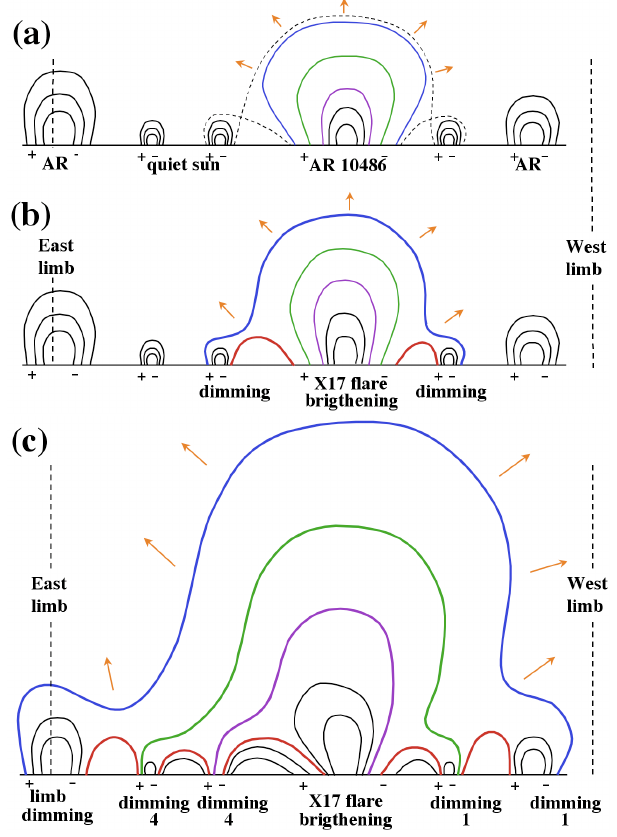
Fig. 15. Dimming spreading due to reconnection (mechanism pro- posed by Attrill et al., 2007, applied to the 28 October 2003 event). (a) The CME lift-off. AR 10486 is represented by five field lines, while nearby bipoles are represented with three black field lines. The dashed lines represent the separatrices involved in the next re- connection (drawn symmetric to simplify the drawing). (b, c) Re- connection of the expanding CME field configuration with the sur- rounding bipoles (the just reconnected field lines are thicker and set to red for the short loops). By successive reconnections the outer shell of the CME expanding magnetic field is progressively rooted in more distant regions. This creates the spreading of the dimmings to larger spatial scales ( Mandrini et al.,